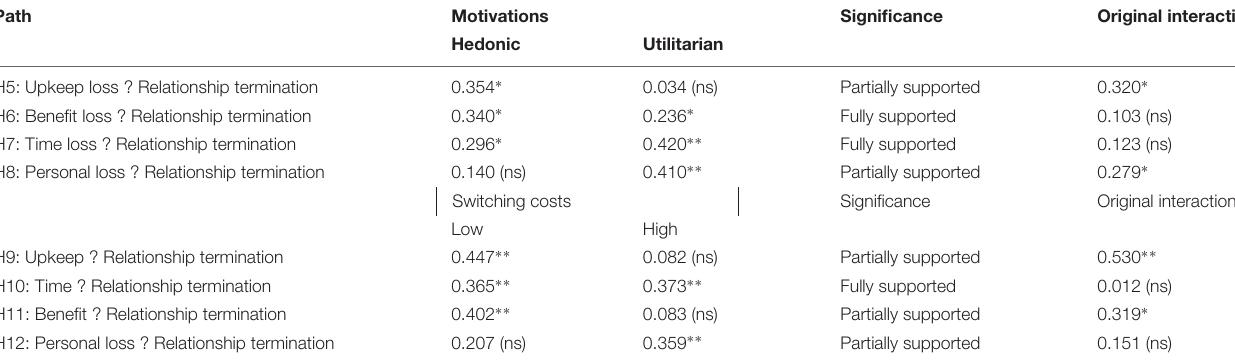
TABLE 5 | Conditional effect of four categories on relationship termination at values of the moderators (by PROCESS = 1).